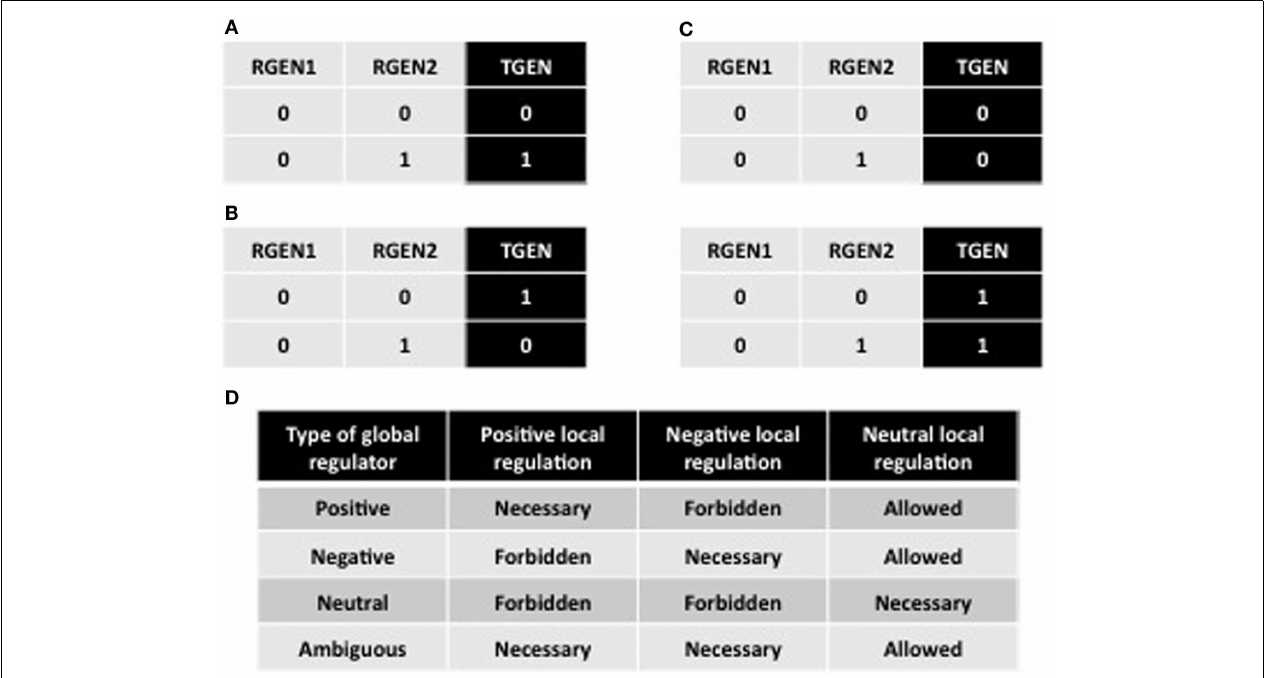
definitions of global regulators based on local regulator definitions.The table shows which types of local regulations are necessary, allowed, or forbidden for each type of global